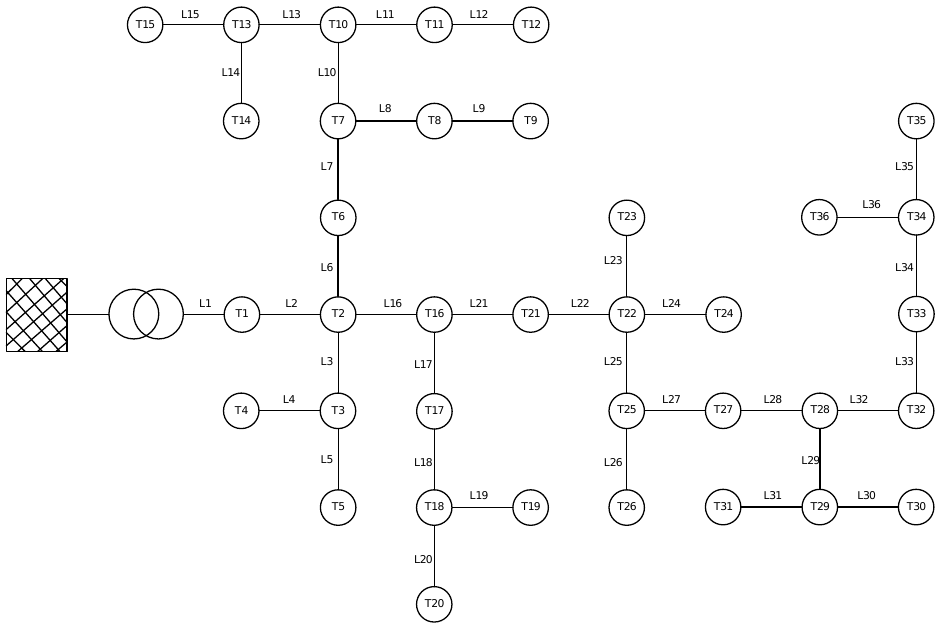
Figure 9. Studied distribution grid layout.